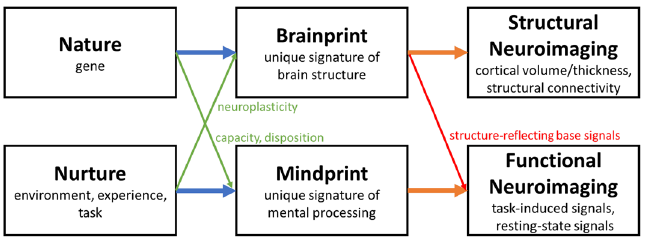
Figure 1. Conceptual illustration of brainprint versus mindprint. While structure-reflecting brainprints are often measured by structural neuroimaging, the current study observes brainprints in the signals of functional neuroimaging. Moreover, both nature and nurture can shape brainprints and